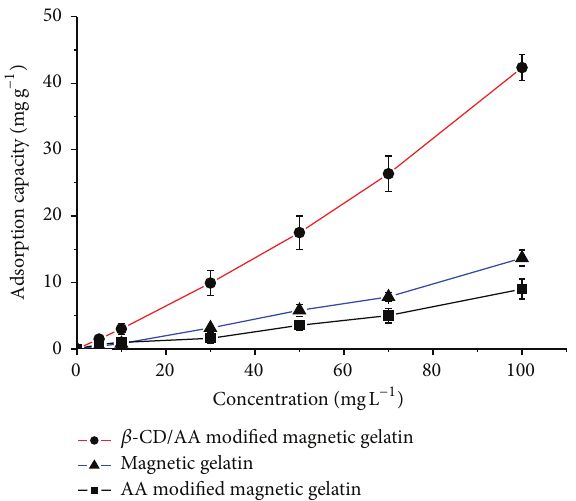
Figure 2: Adsorption isotherm of MOX onto the magnetic compos- ites.